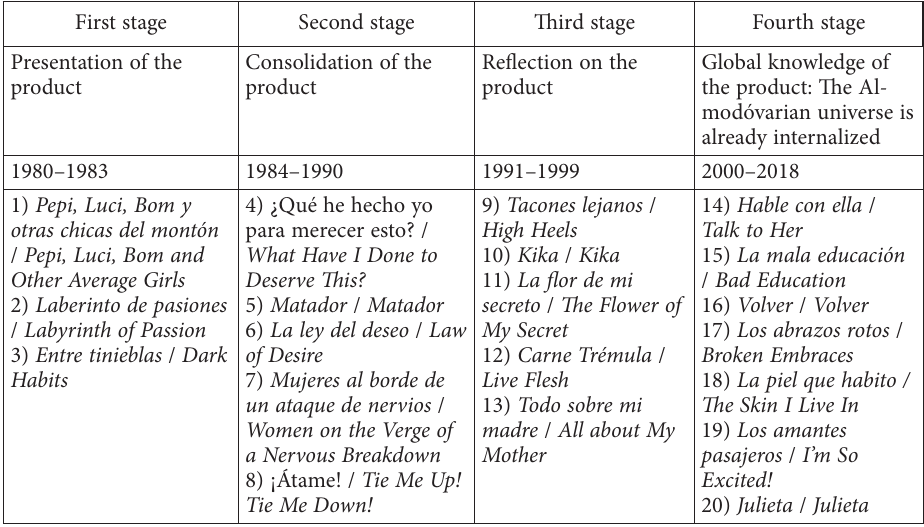
Table 1. Creative stages of Pedro Almodóvar (source: created by authors) First stage Second stage Third stage Fourth stage Presentation of the